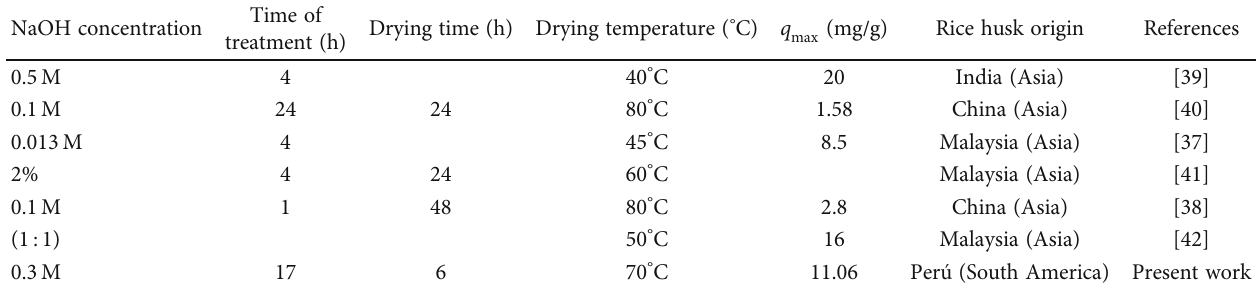
Table 7: Comparison of maximum adsorption capacity of several treated rice husks from di ff erent geographical regions and variable experimental